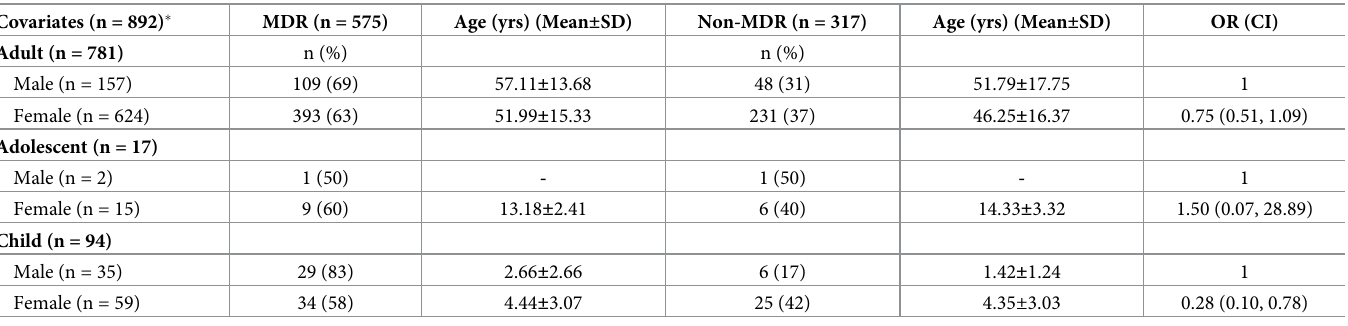
Table 3. Prevalence of MDR community-acquired UTI among patients according to different age and sex groups. Covariates (n = 892) � MDR (n = 575) Age (yrs) (Mean ±